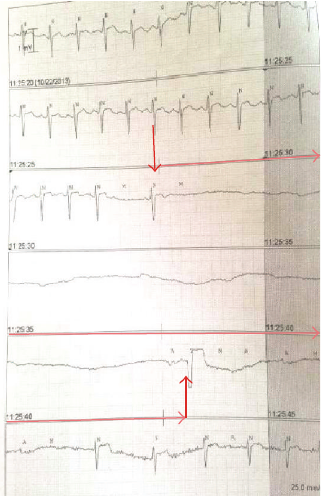
Figure 2: EKG strips with arrows outlining progression of severe bradycardia to transient asystole with return of sinus rhythm